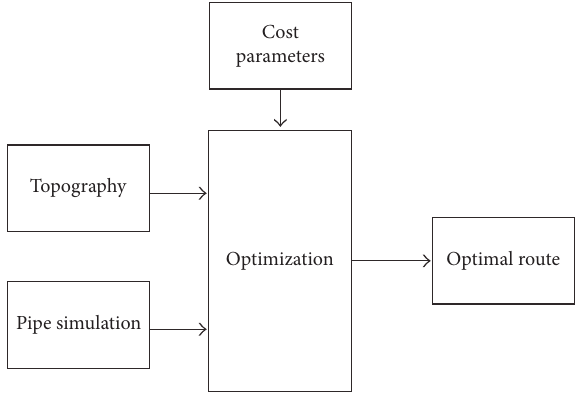
Figure 1: Optimization